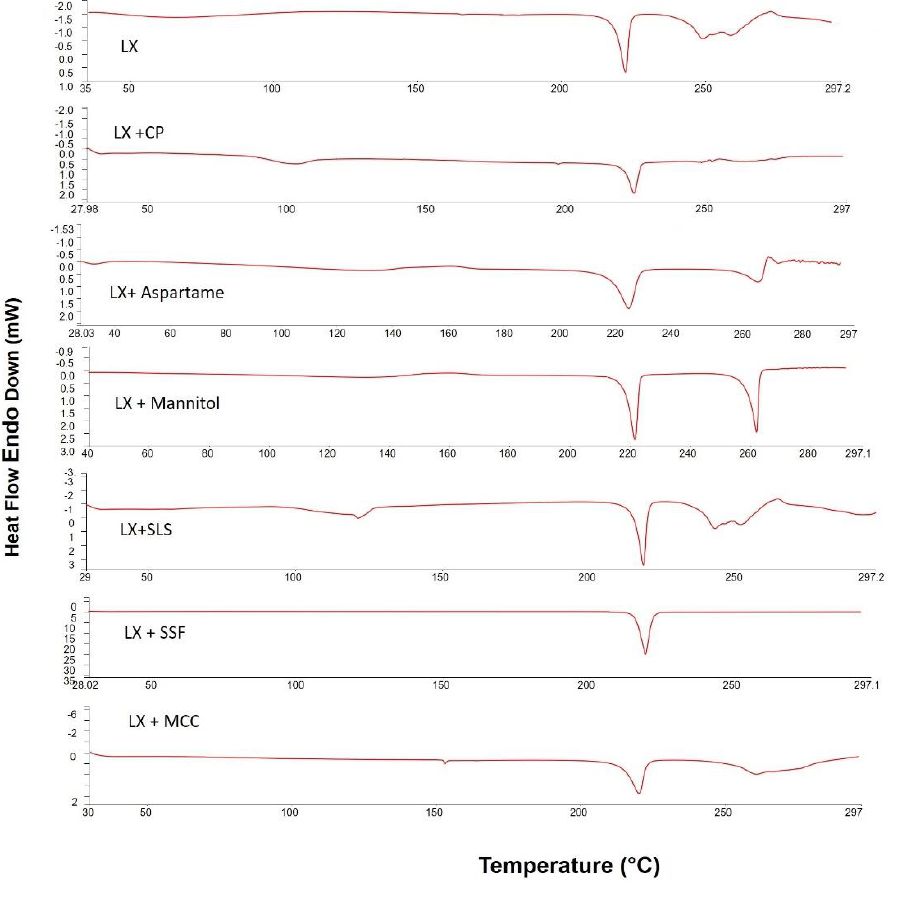
Figure 2. Differential scanning calorimetric thermograms of pure LX; LX + CP; LX + Manitol; LX + MCC; LX + SLS; LX + Aspartame; and LX+SSF.